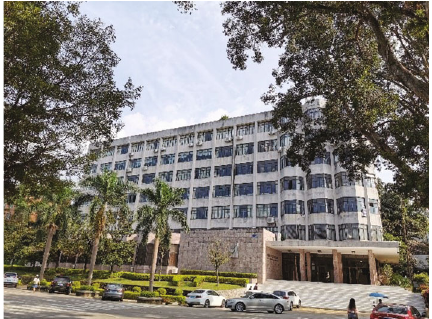
Figure 3: The seven-story classroom building under investigation. N